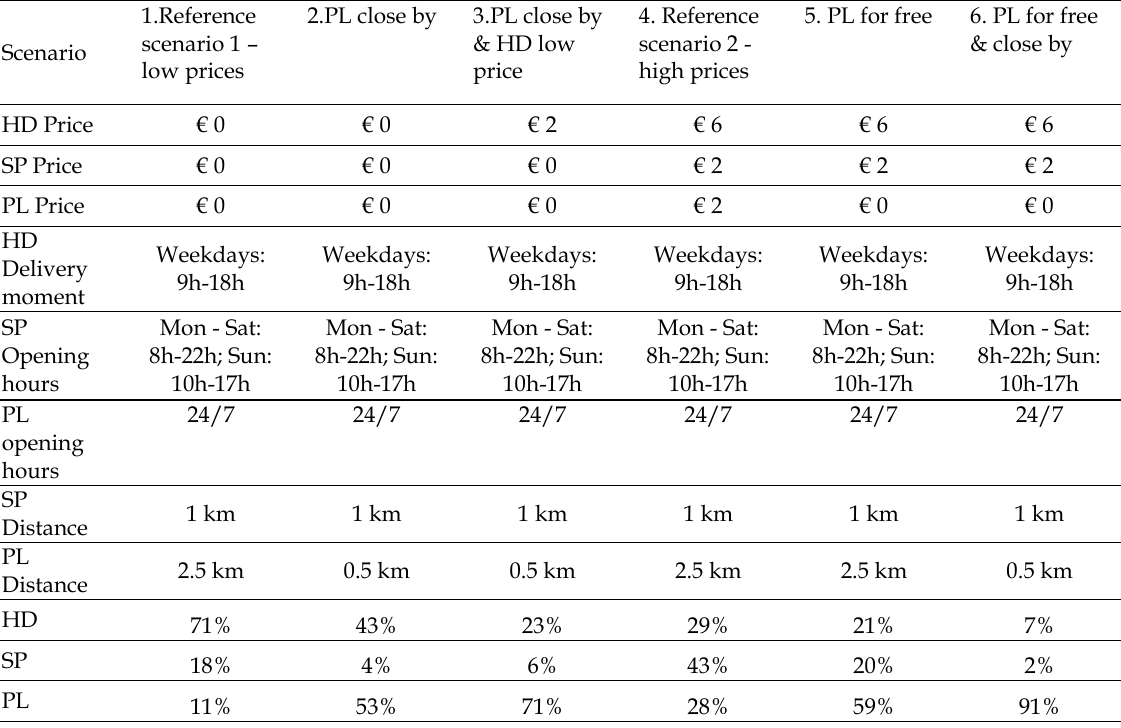
Predicted shares of delivery options under six